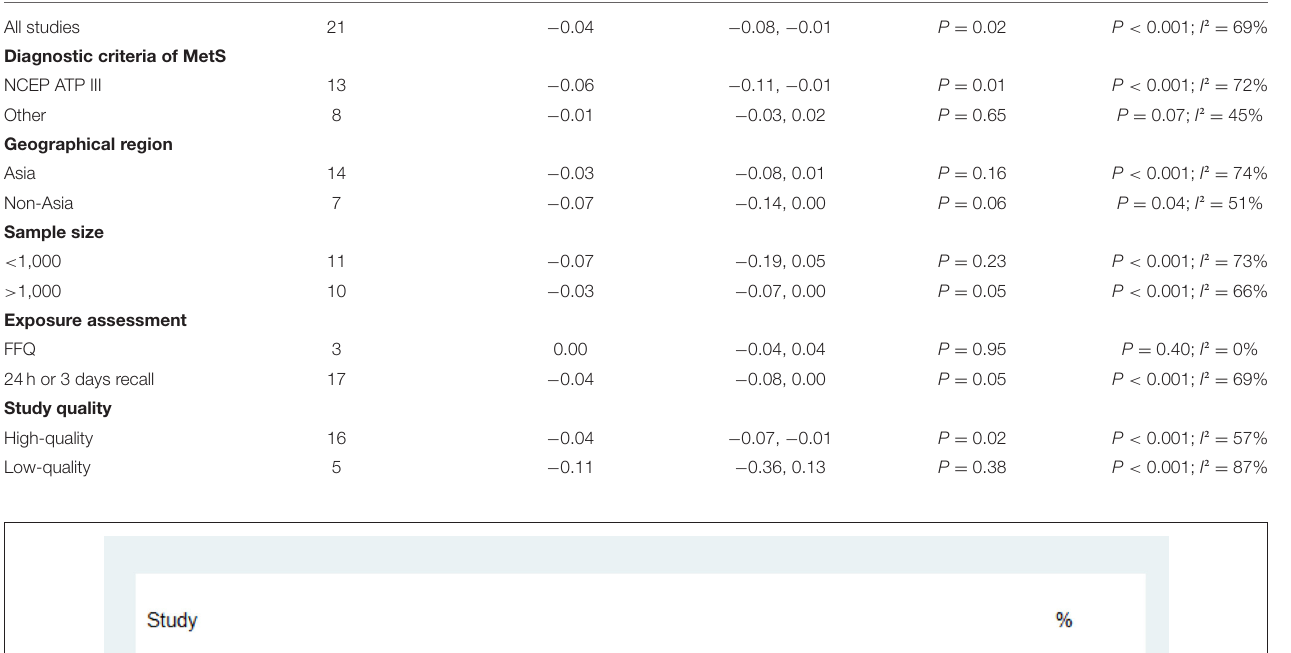
TABLE 2 | Subgroup analysis for standard mean difference (SMD) of dietary vitamin C level in MetS vs. control subjects. Stratification Pooled SMD Heterogeneity